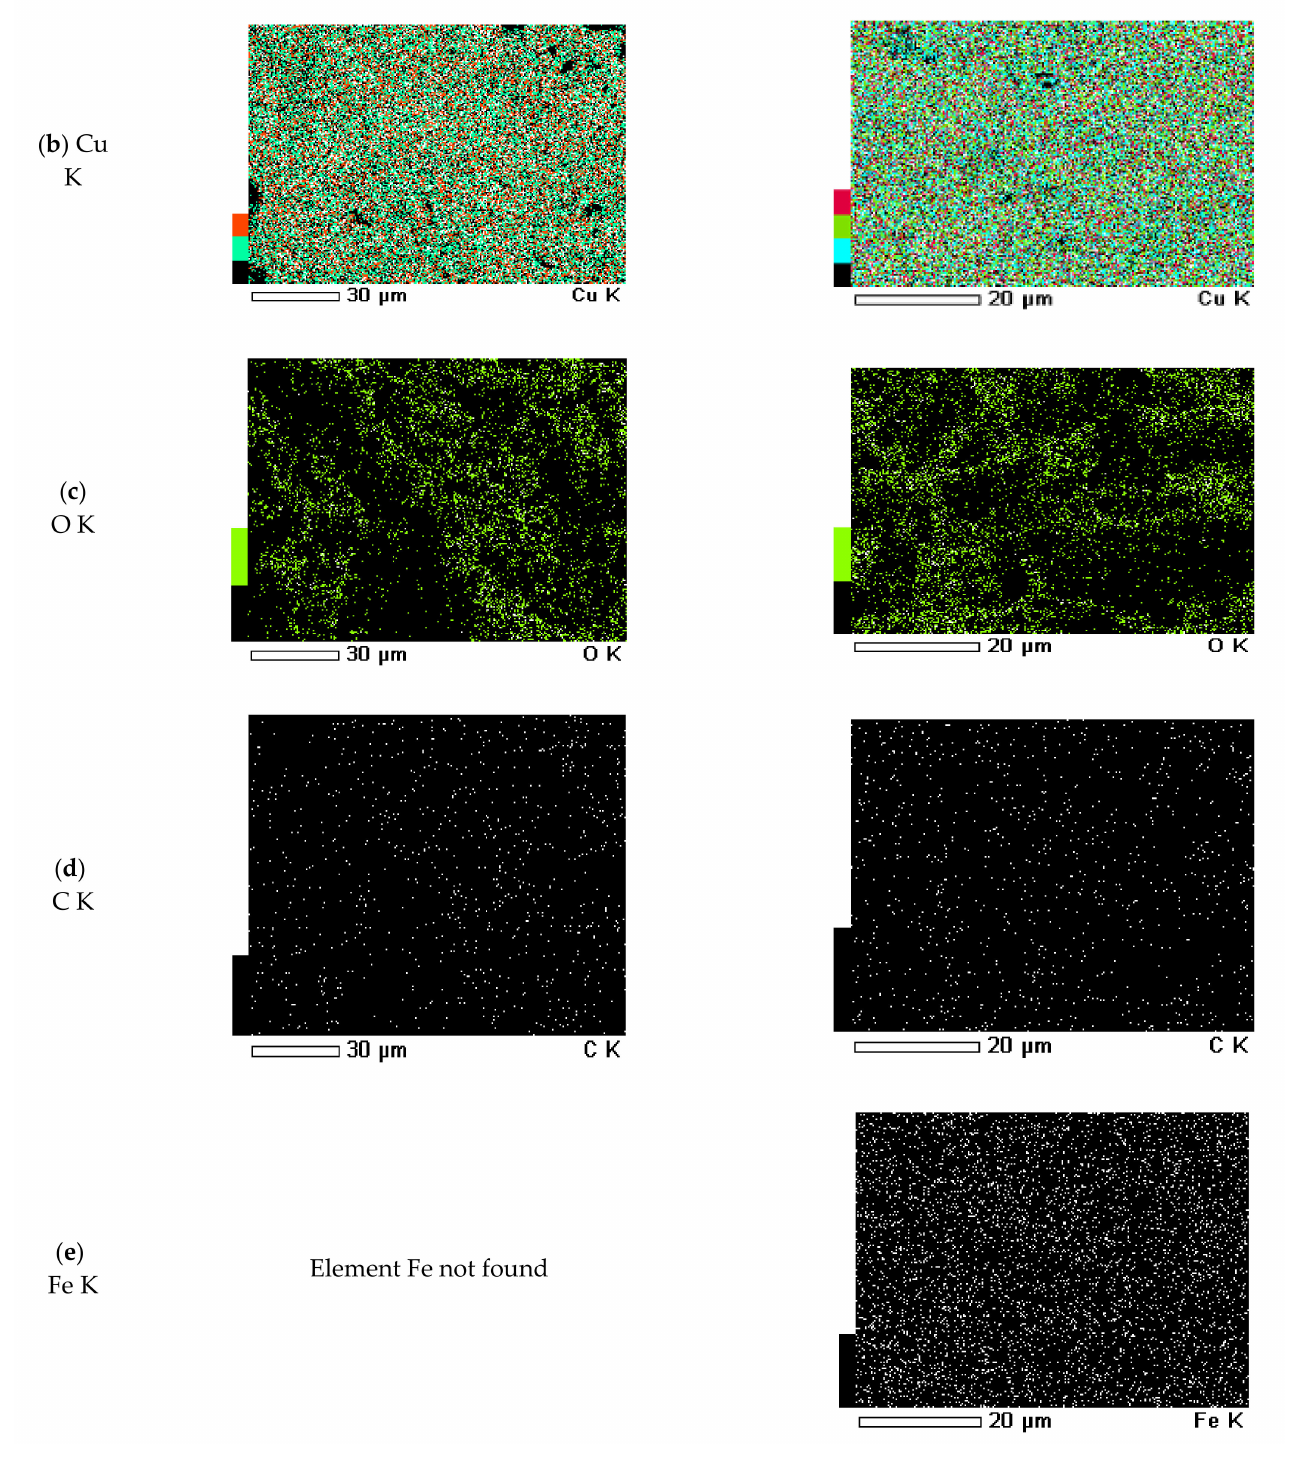
Figure 5. Energy dispersive spectrometry (EDS) elemental mapping analyses of the samples C1 and